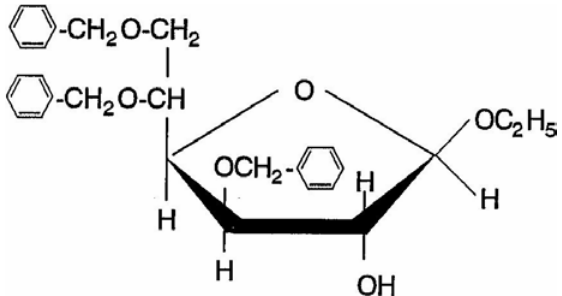
Figure 1. Chemical structure of tribenoside [ 4